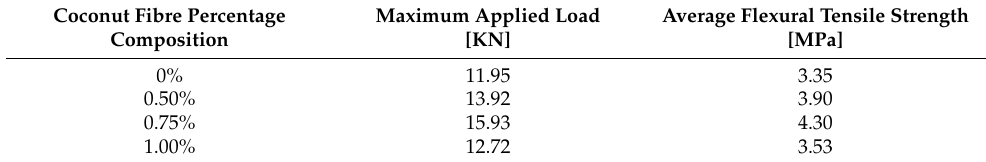
Table 8. Flexural tensile strength of beam test